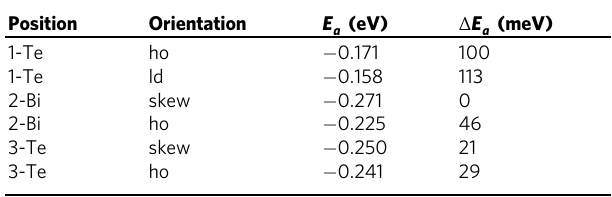
The adsorption energy E a and the energy difference Δ E a relative to the most favourable adsorption site for H 2 O on Bi 2 Te 3 . The table shows adsorption on top of the fi rst layer Te atom (1-Te), the second layer Bi atom (2-Bi) and the third layer Te atom (3-Te). The optimised orientations of the H 2 O molecule on the according positions are horizontal (ho), with a single OH bond pointing down (ld) or at an intermediate angle (skew) — i.e. with the OH bond being neither perpendicular nor horizontal to the